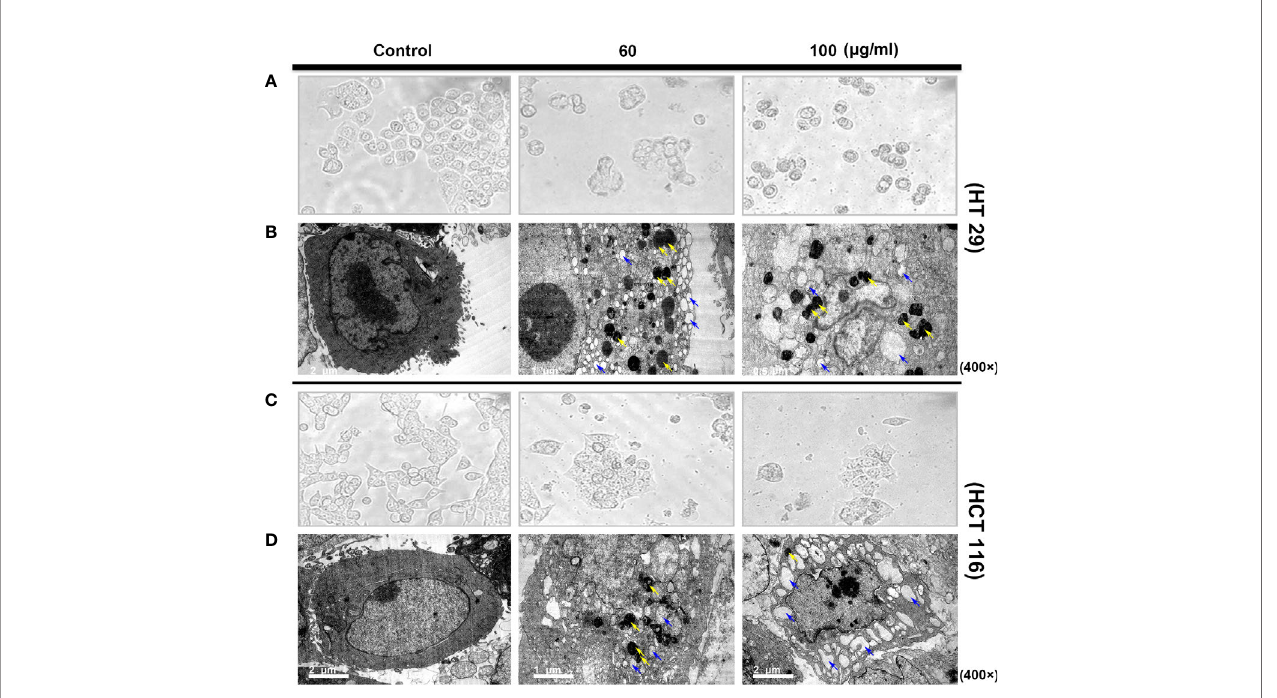
FIGURE 2 | Morphological structure (A, C) and ultrastructural changes [ (B, D) TEM images of autophagosome and autolysosome cells] in human colon cancer cells treated with SDEA under different concentrations for 24